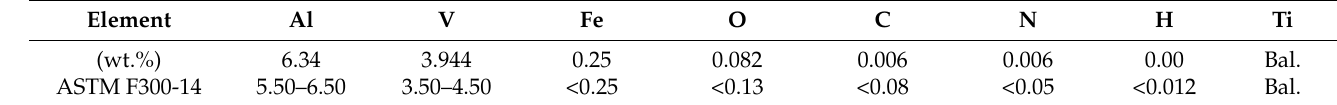
Table 1. Composition of Ti6Al4V(ELI) alloy powder as supplied by TLS Technik GmbH and that of ASTM F3001-14.